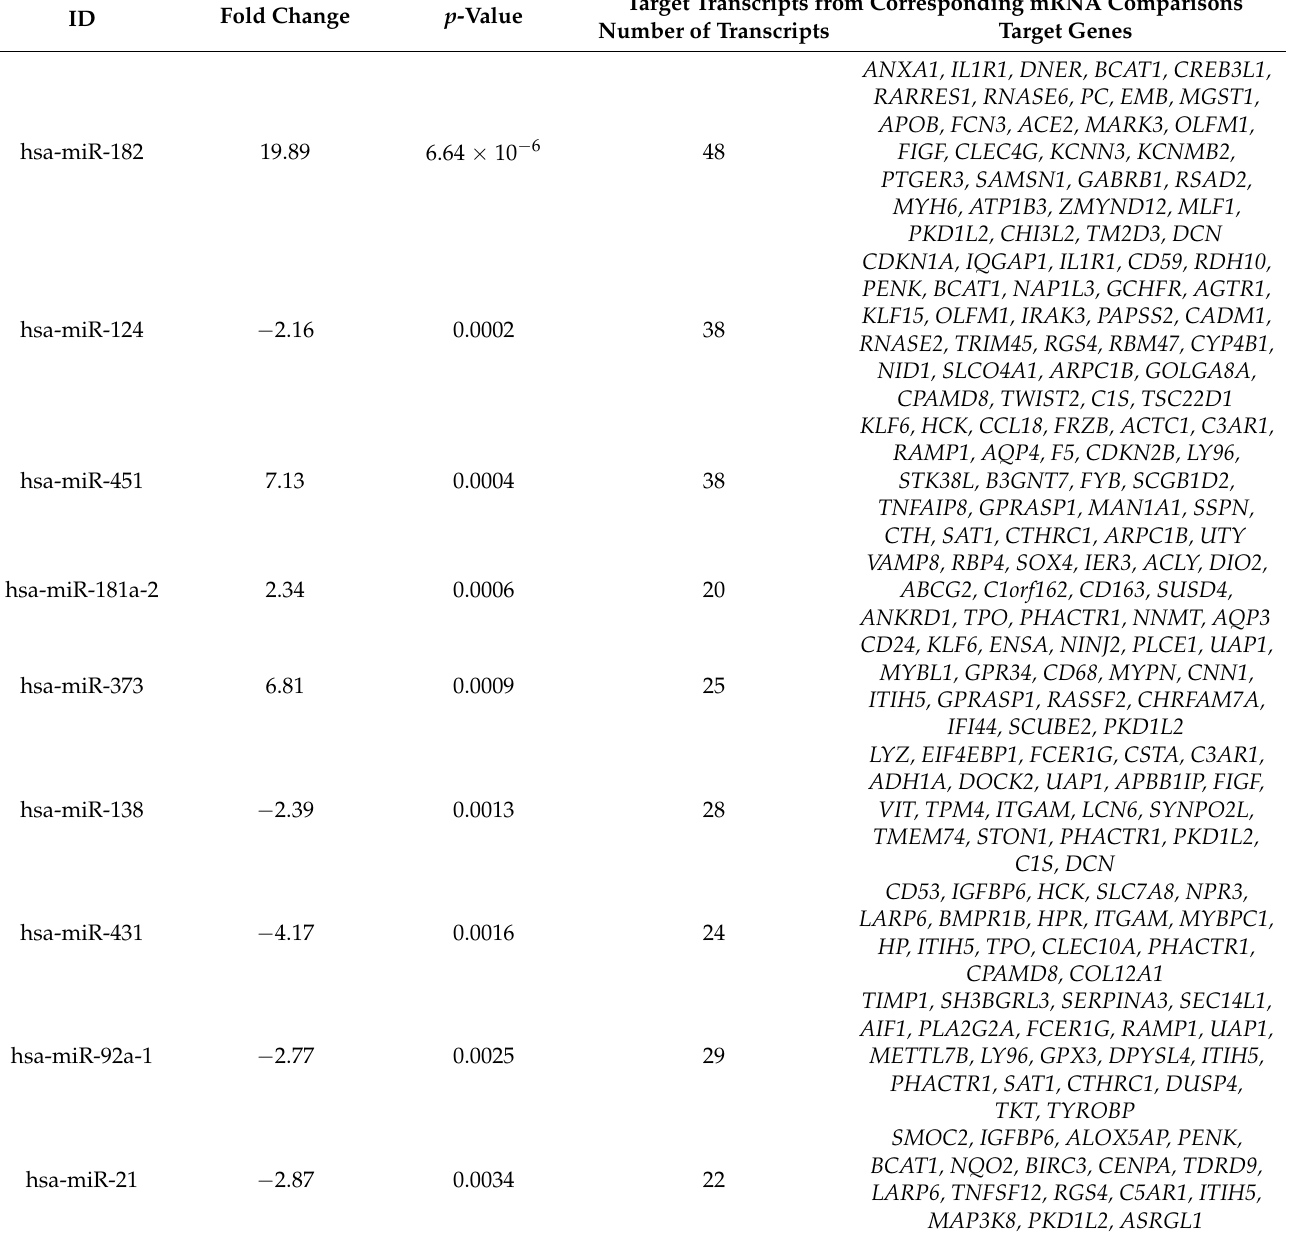
Table 3. Pathological miRNAs in the RV of DCM hearts and their corresponding target